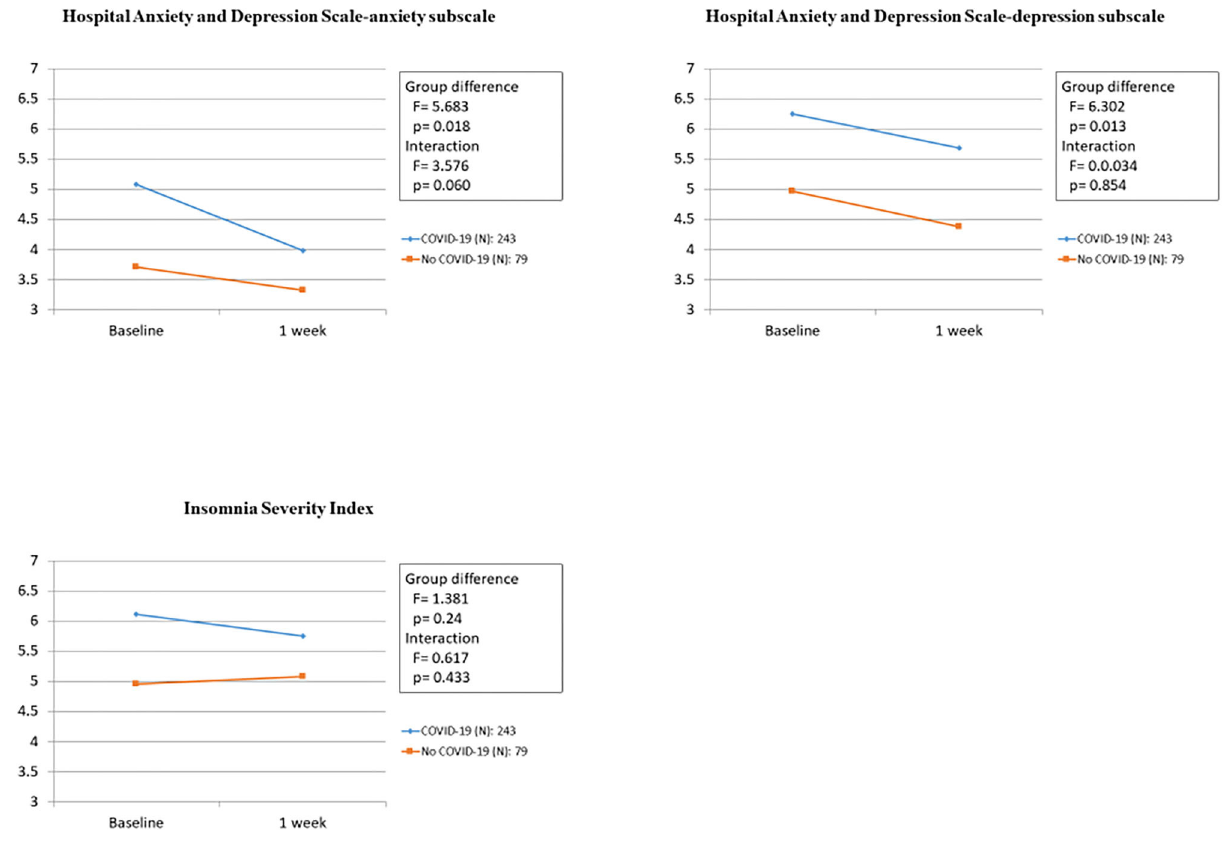
sex, employment status, previous history of psychiatric problems, and rheumatic disease. Figure 3 shows the changes in suicidal ideation between baseline and 1 week. Compared to baseline, significant improvements were found in suicidal ideation at 1 week. The impacts of psychiatric and physical comorbidities on the HADS (A), HADS (D), and ISI scores